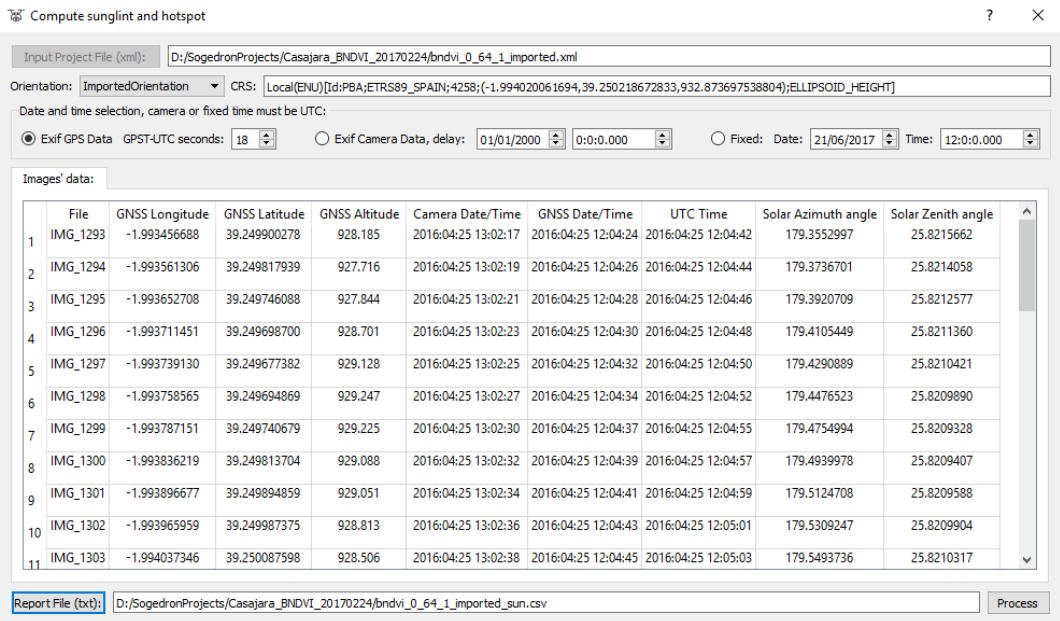
Figure 8. Solar positioning (azimuth and elevation) for the study case analyzed.